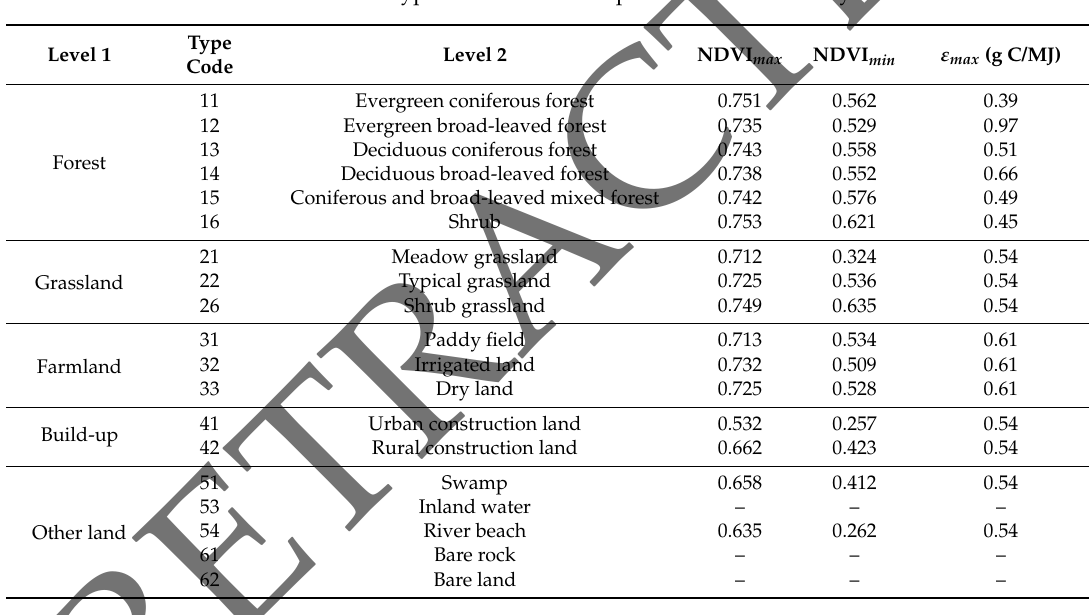
Table 2. Land cover types and NPP model parameters in the study